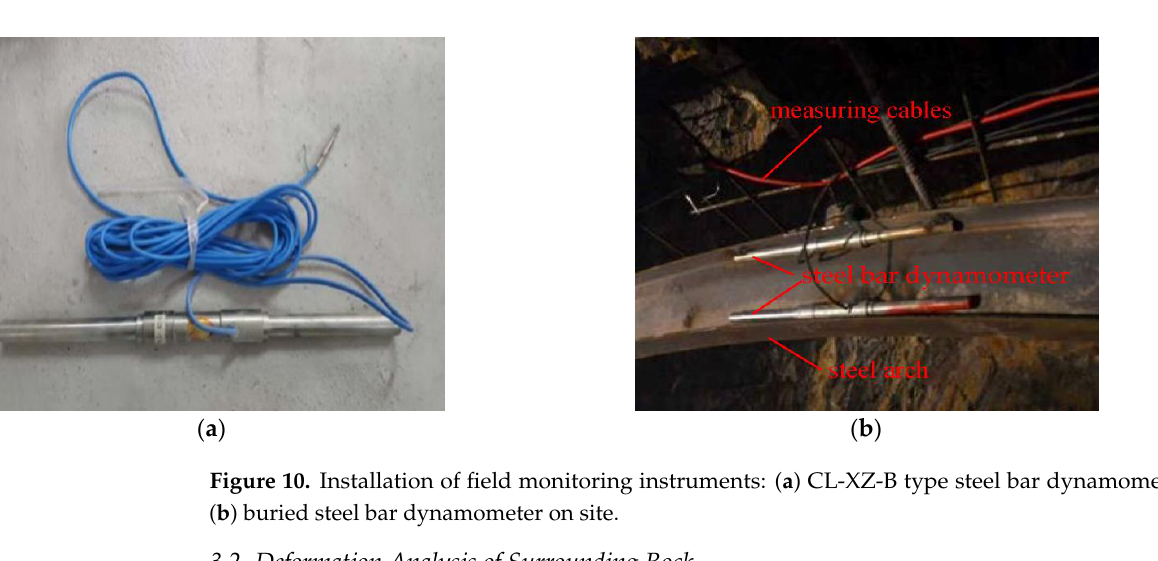
Figure 10. Installation of field monitoring instruments: ( a ) CL-XZ-B type steel bar dynamometer; ( b ) buried steel bar dynamometer on site.